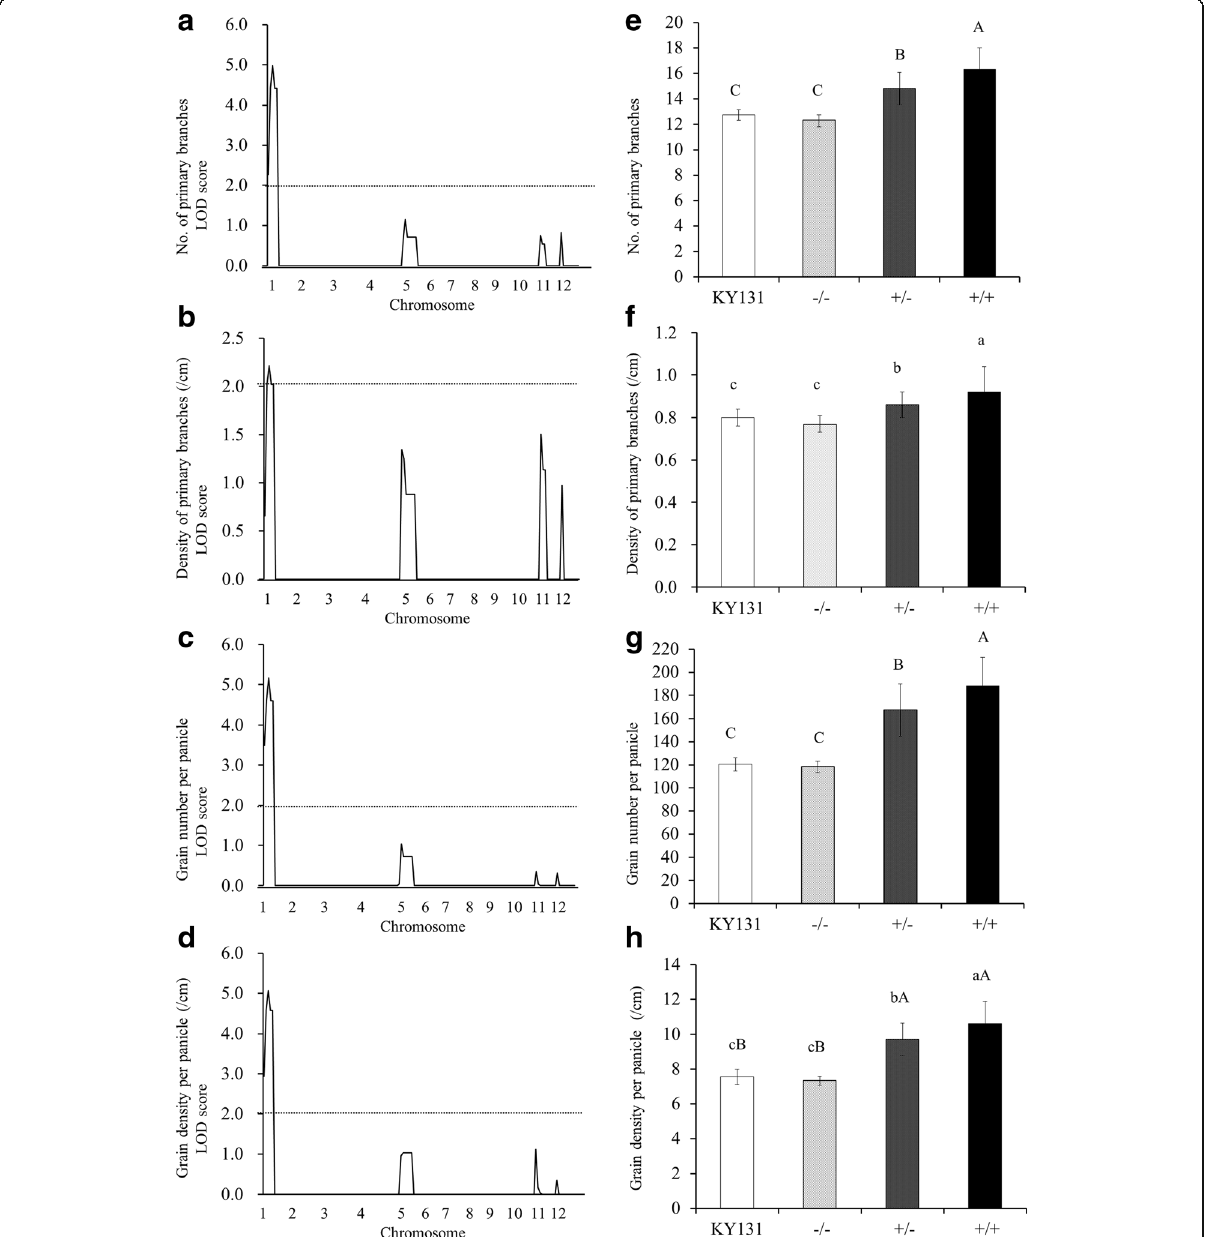
Fig. 4 Marker-trait analysis of the random subpopulation BC 3 F 2 -LQ96 derived from BC 3 F 1 -22F01 using Kongyu 131 as the recurrent parent and GKBR as the donor parent. a - d LOD score of 4 yield-related traits; the horizontal axis represents the 160 SNP markers on 12 chromosomes. e - h Comparison of 4 yield-related traits of Kongyu 131 and three genotypic classes of the Gn1a locus. − / − represents homozygote for Kongyu 131, +/ − represents heterozygote, and +/+ represents homozygote for GKBR. a and e Number of primary branches per panicle (NPB). b and f Density of primary branches (DPB, /cm). c and g Grain number per panicle (GNP). d and h Grain density per panicle (GDP, /cm). e - h A, B, C ranked by Student ’ s t-tests at P ≤ 0.01; a, b, c, ranked by Student ’ s t-tests at P ≤